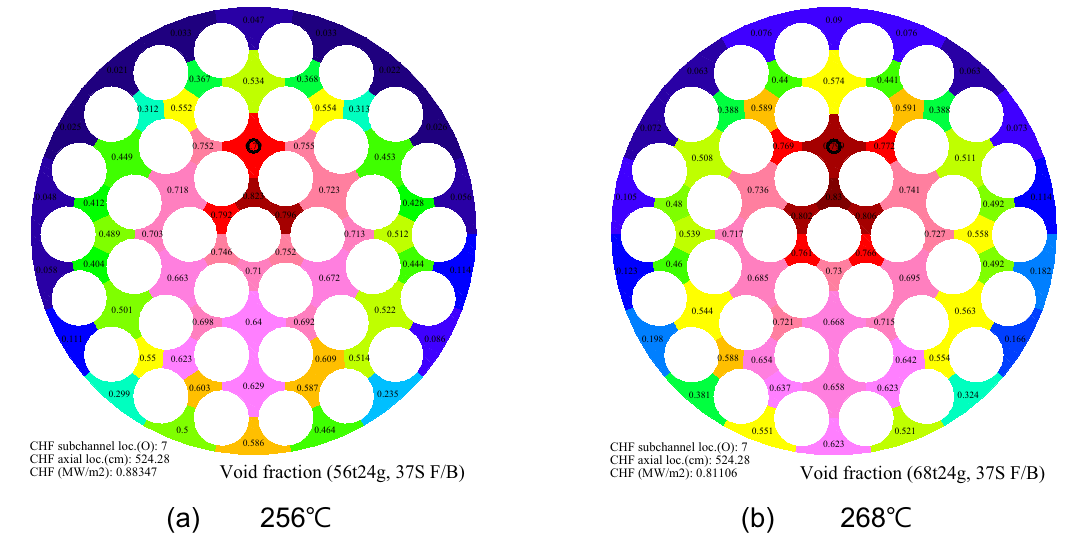
Fig. 8. Void fraction of a 37S fuel bundle for the 5.1% crept pressure tube at 24